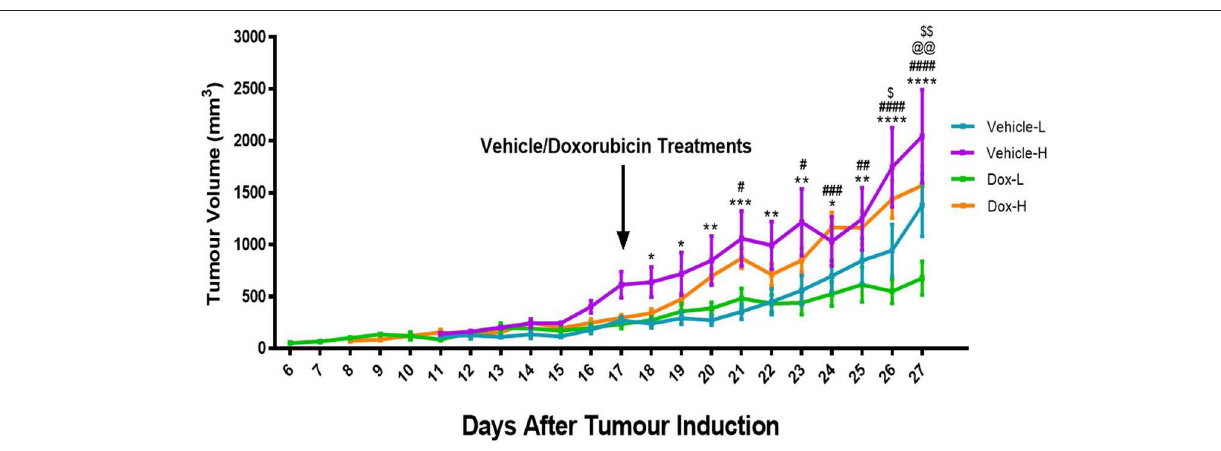
Frontiers in Oncology |